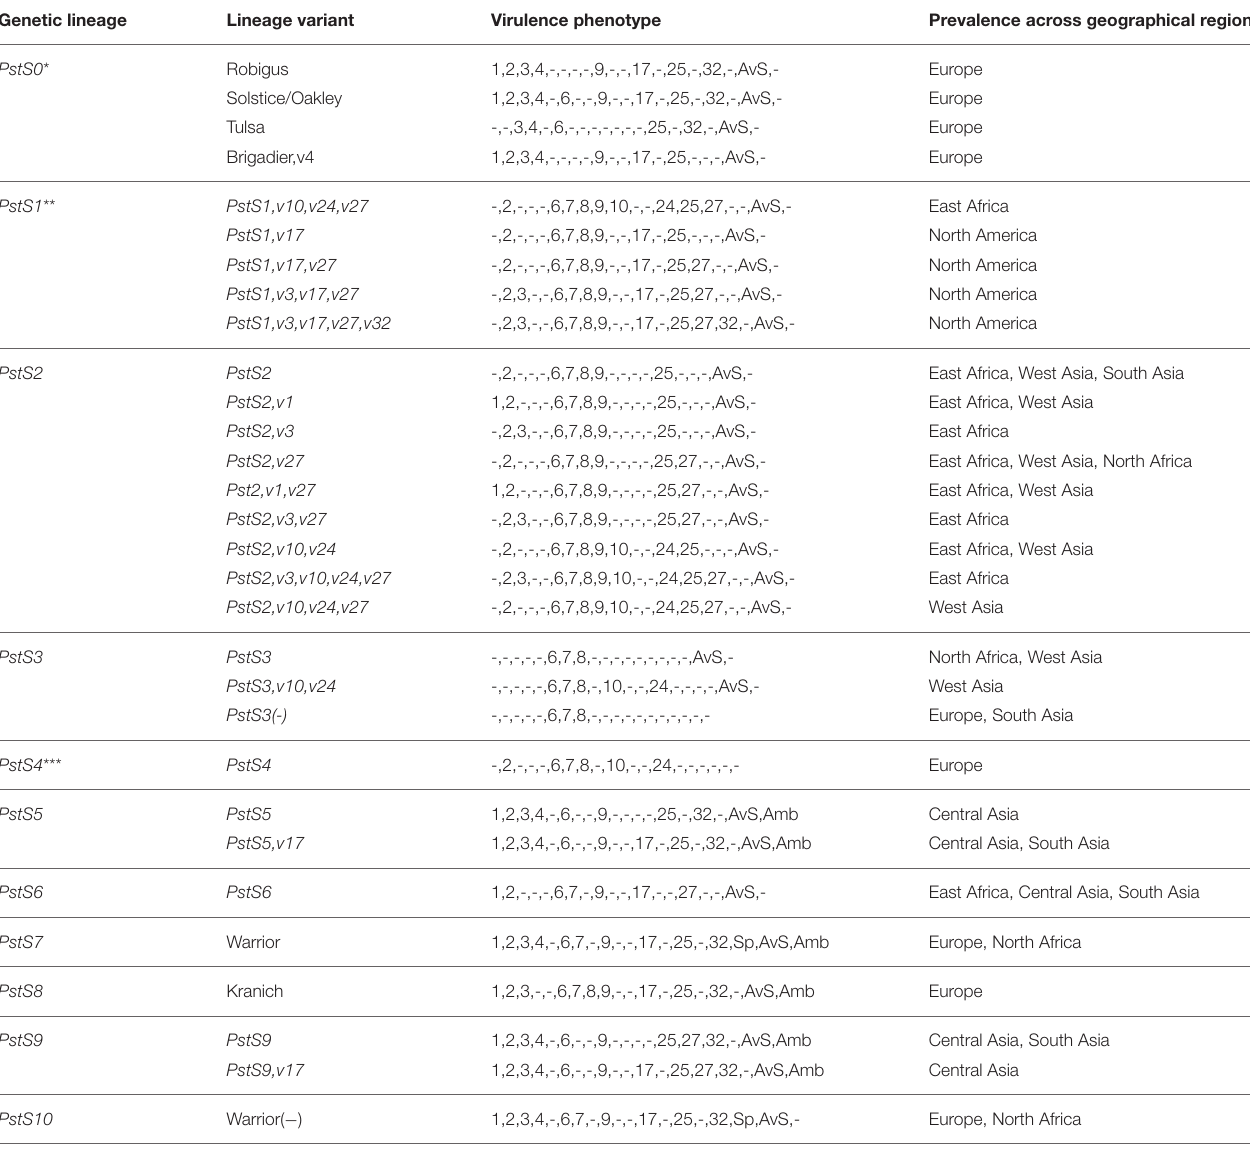
TABLE 2 | Characteristics of regionally important P. striiformis lineages and virulence variants prevalent during 2009–2015. Genetic